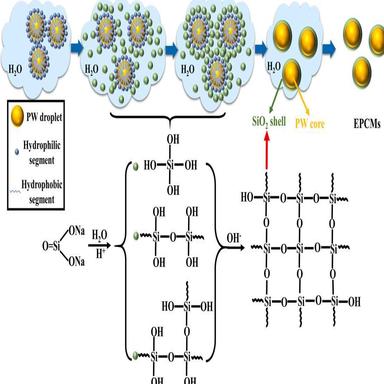
Schematic illustration of preparing the EPCMs.